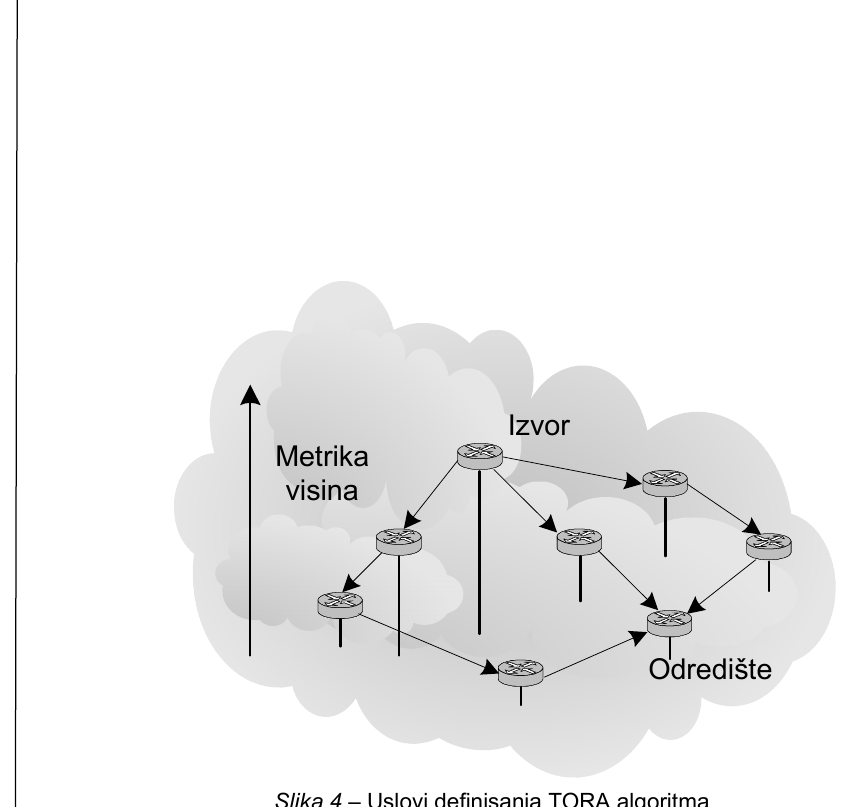
Figure 4 – Conditions for the TORA